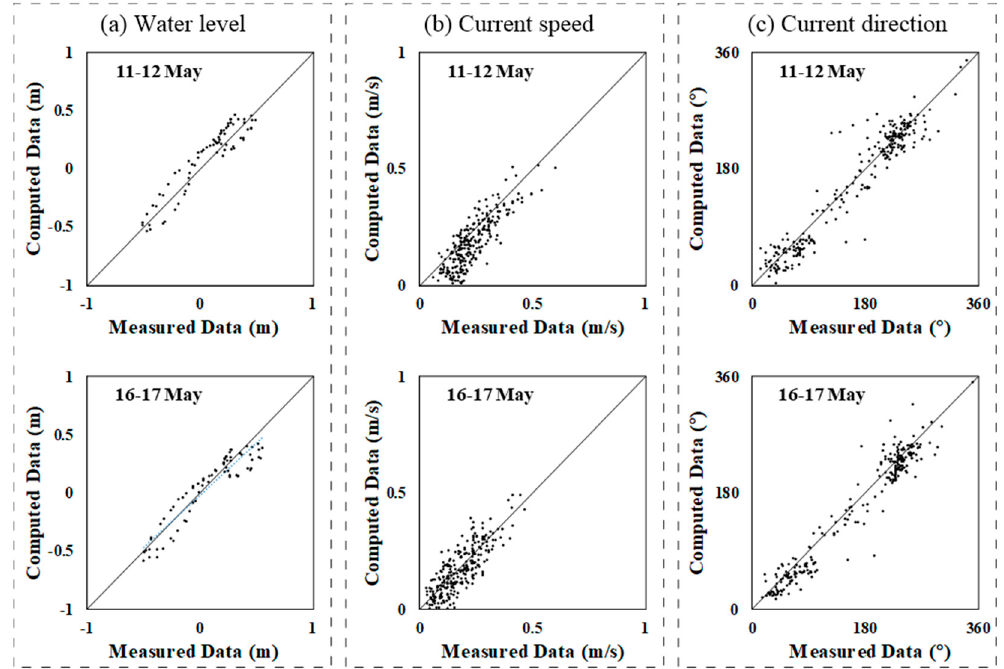
Figure 3. Linear correlation between computed and measured water level, current speed, and current direction on 11–12 May (upper) and 16–17 May (lower) in 2013.